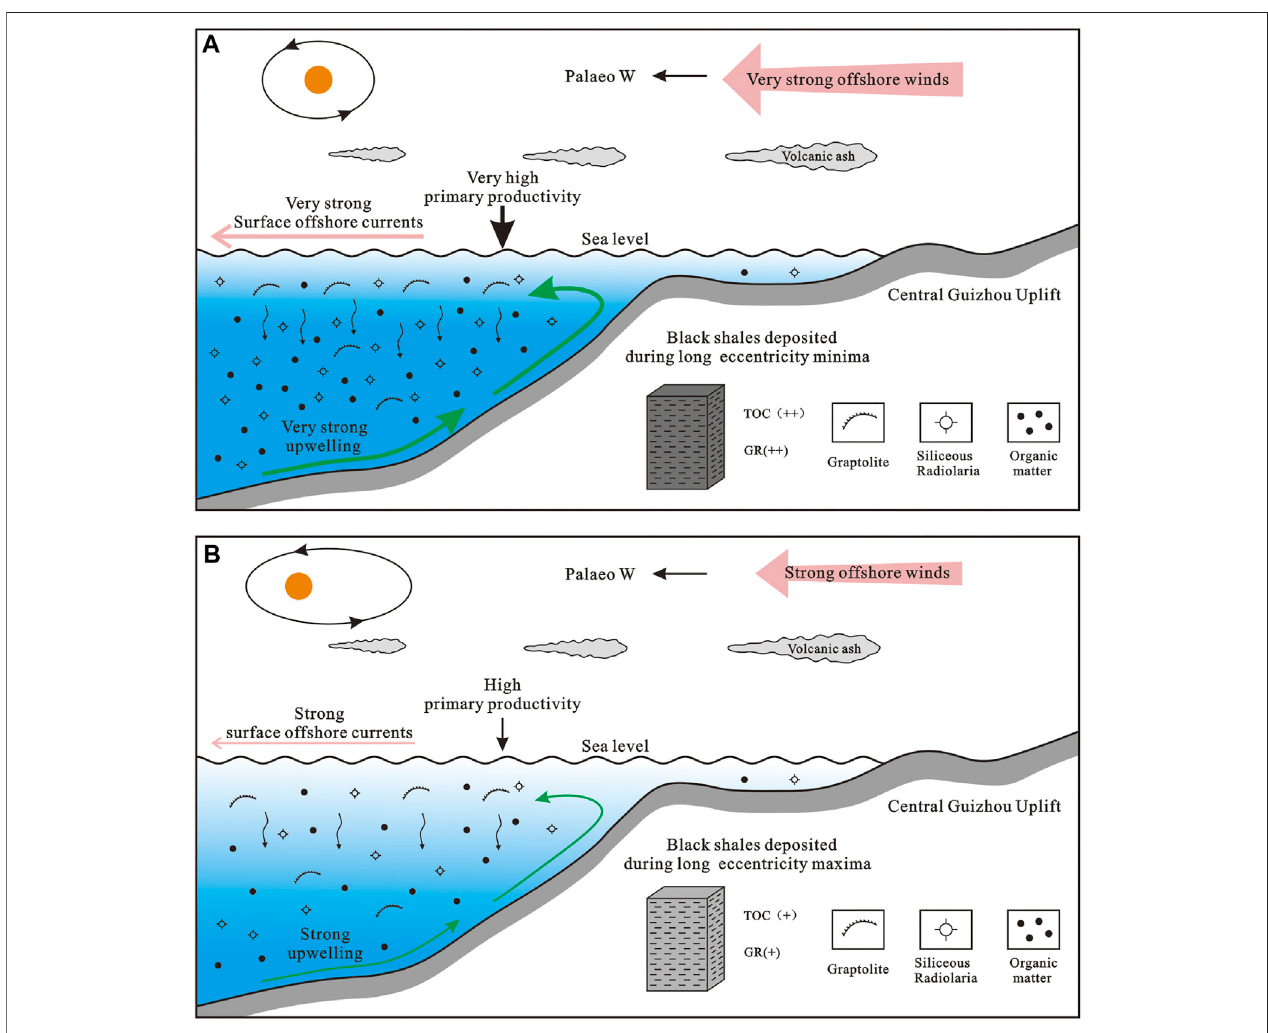
FIGURE 9 | Paleoenvironmental modes during the deposition of the Wufeng – Longmaxi Formation black shales at an orbital scale. (A) Paleoenvironmental mode during long eccentricity minima. (B) Paleoenvironmental mode during long eccentricity maxima.